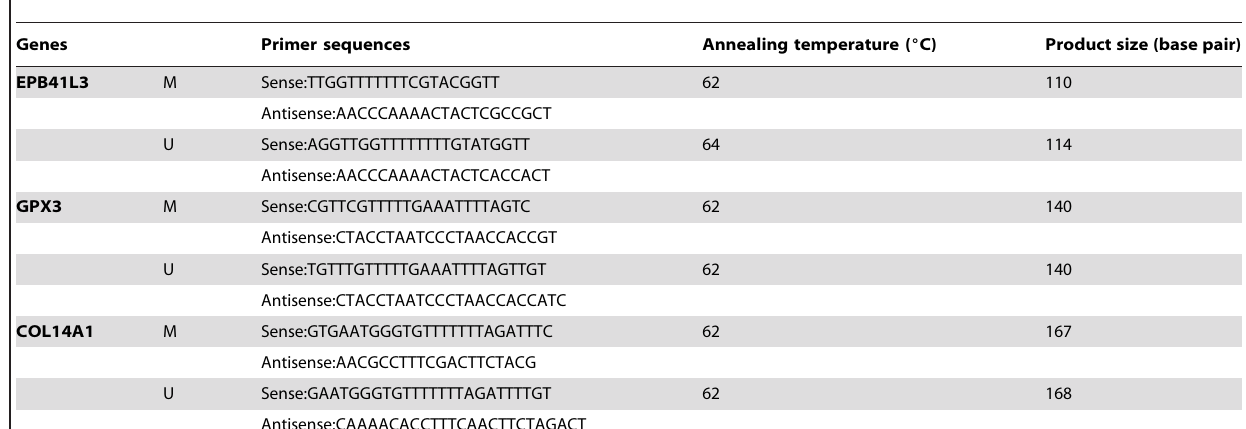
Table 2. Primer and Probe Sequences of Genes Related to Esophageal Squamous Cell Carcinoma.